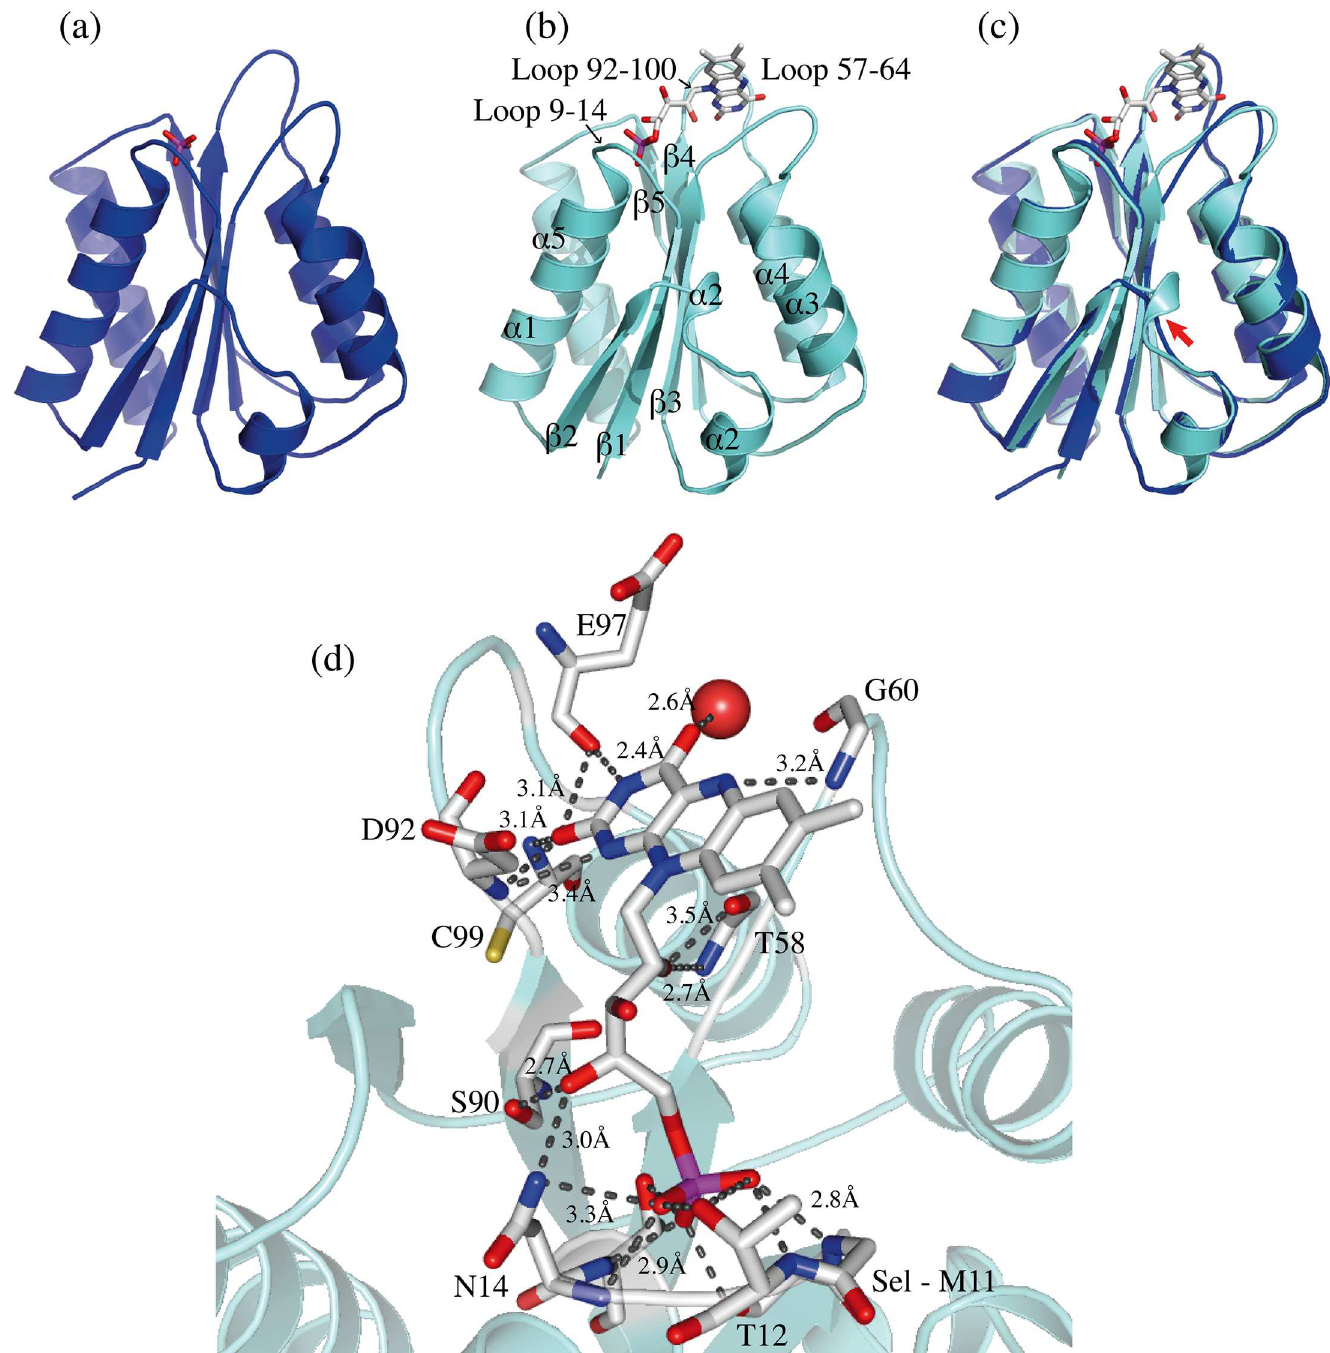
Fig 6. Ribbon structure representation of apo S p Fl in blue (a) and holo S p Fld in cyan (b). Changesin the key FMN bindingloops indicated in (b) can be observed in the structural superimposition of the holo (cyan) and apo (blue) flavodoxins shown in (c). Also in (c), a red arrow points to a short 3 10 helix formed in the holoprotein. The FMN- Sp Fld hydrogen bondinginteractions are highlighted in